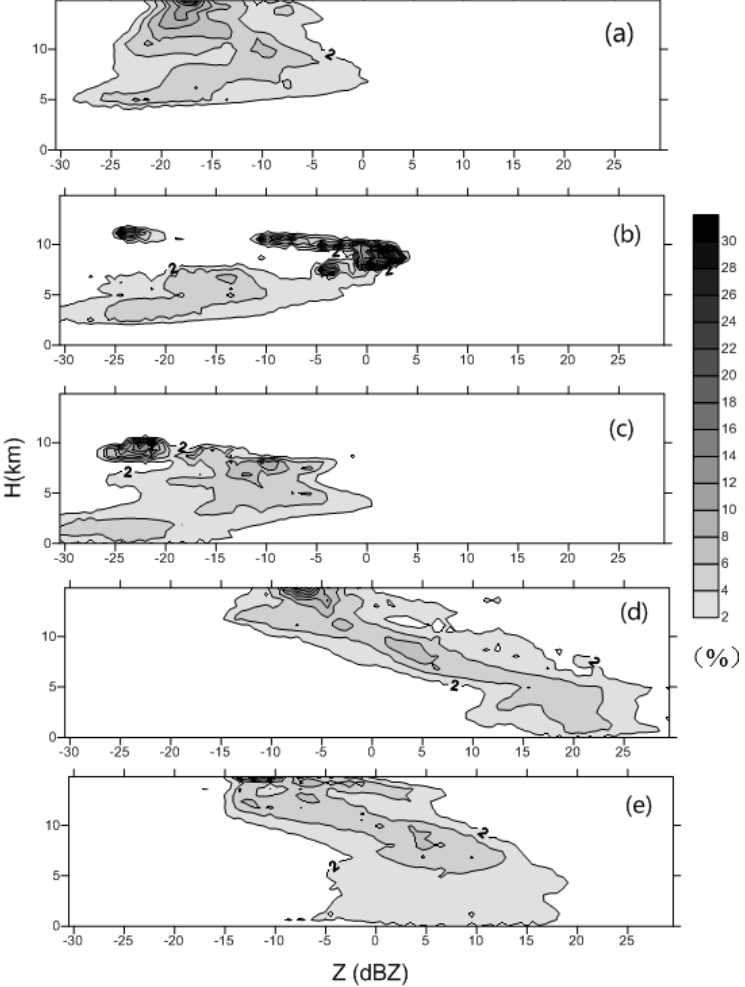
Figure 18. Normalized CFADs (%) of reflectivity of non-precipitating and precipitating clouds based on merged data during July 2016: ( a ) high-level non-precipitating clouds; ( b ) mid-level non-precipitating clouds; ( c ) low-level non-precipitating clouds; ( d ) convective precipitating clouds; and ( e ) stratiform precipitating clouds.